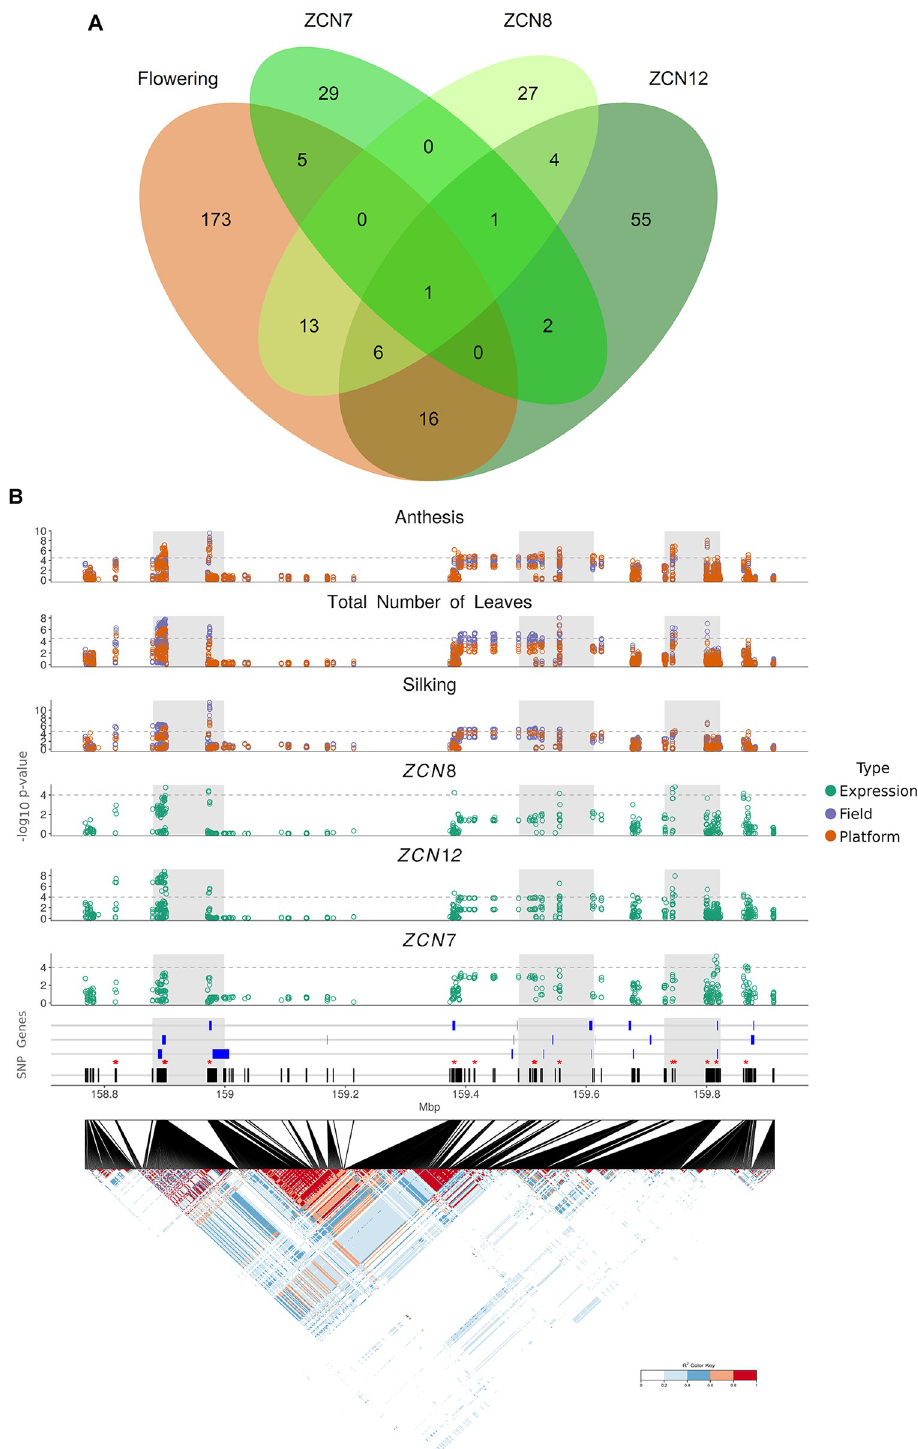
Fig 4. ZCN eQTLs are major contributors to the genetic variance of flowering time. (A) ZCN -related QTLs overlap with flowering time QTLs. Venn diagram highlights ‘meta-QTLs’ shared among flowering-related traits and ZCN transcripts accumulation. “Flowering” meta-QTLs are defined as regions containing at least one QTL among anthesis, silking, total number of leaves in at least one experiment (platform, field, years). “ ZCN- ” meta-QTLs are defined as regions containing at least one ZCN - eQTL in at least one experiment (platform 2014–2015) and leaf stage.